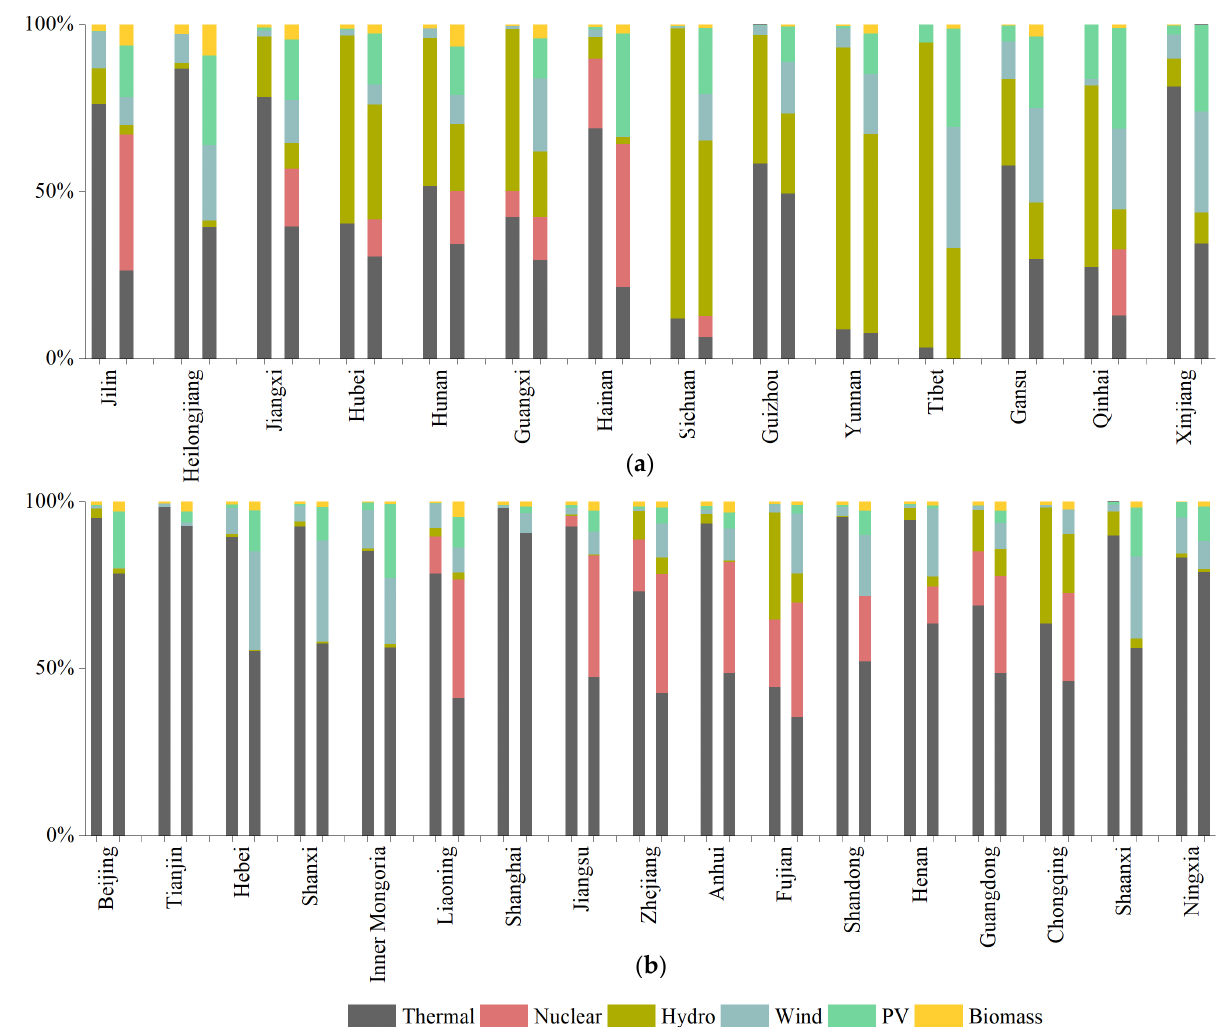
Figure 5. Power Generation Structure of 31 Provinces in a Key Year. (The two columns of each province correspond to 2016 and 2040 from left to right). ( a ) Share of thermal power generation < renewable power in 2040 (14 provinces), ( b ) Share of thermal power generation > renewable power in 2040 (17 provinces).